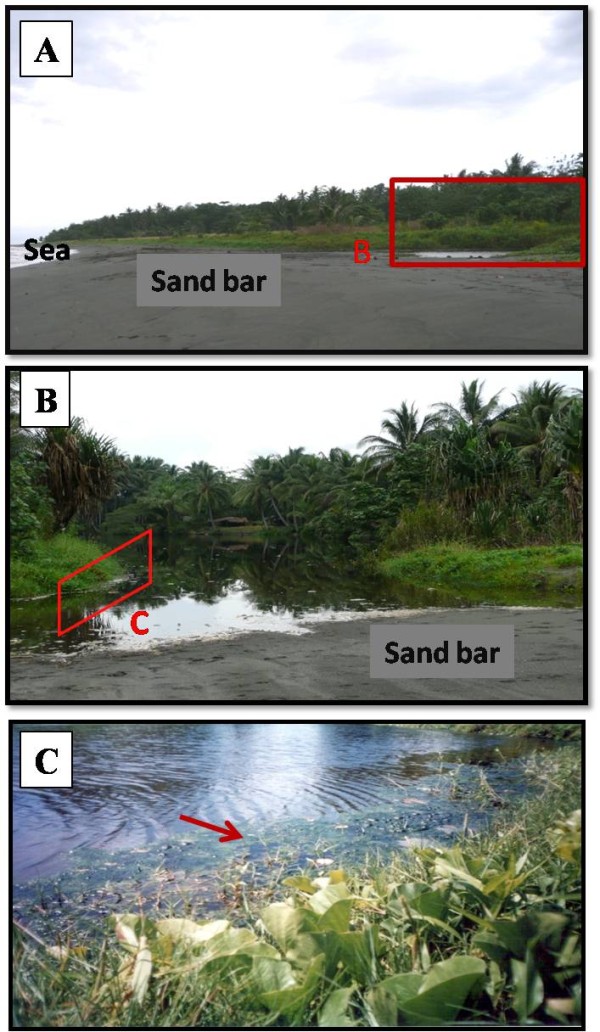
Typical dammed brackish water stream. (A) Lateral view of the dammed stream separated from the sea by sand bar. (B) Showing dammed stream. (C) Floating filamentous algae on dammed brackish water stream margin as indicated by arrow.